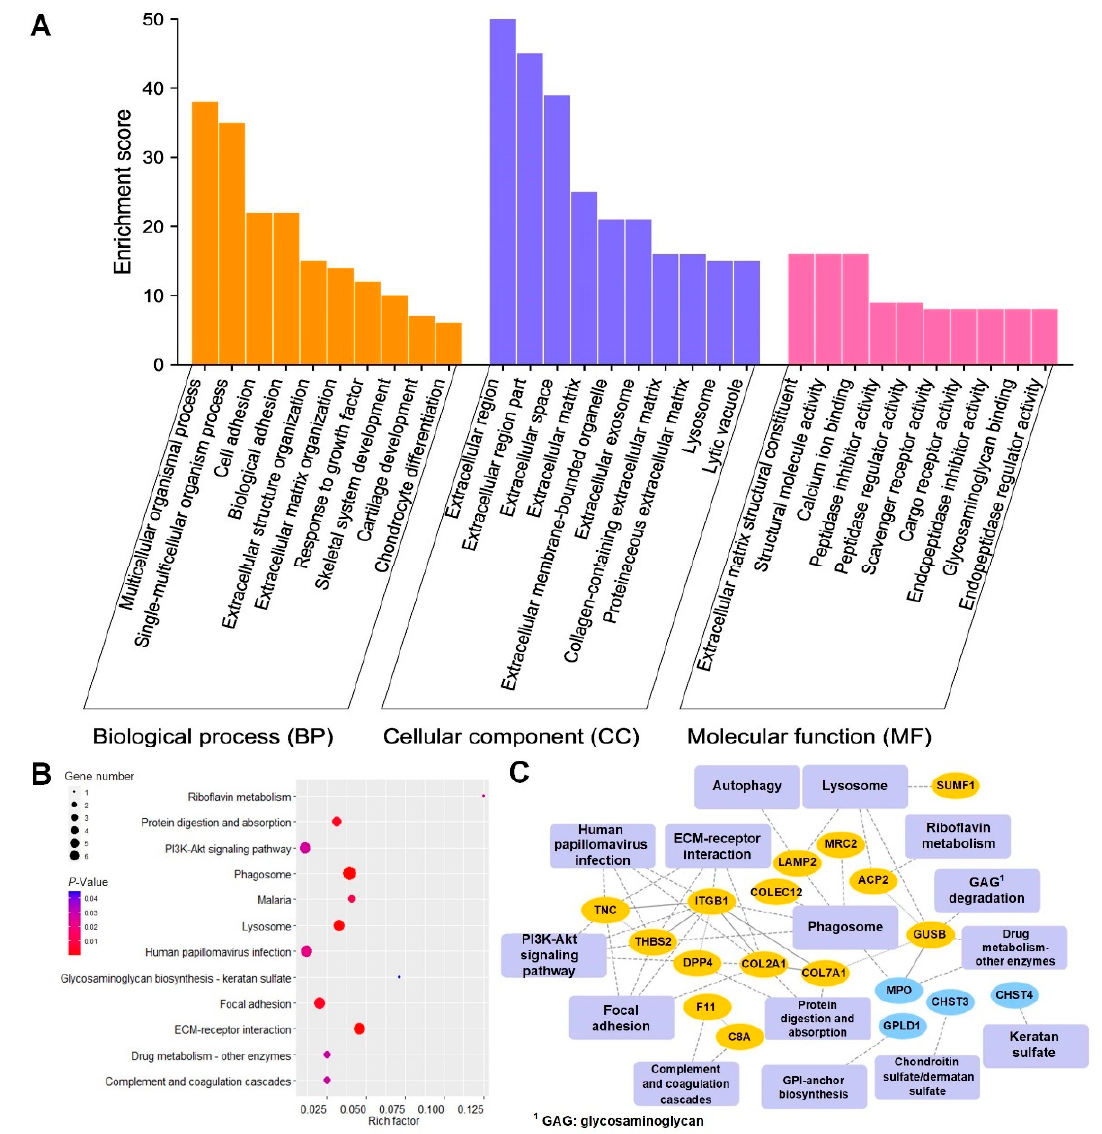
Figure 6. GO, KEGG pathway, and PPI analysis results of differentially expressed N-glycoproteins in KBD vs. N. ( A ) GO analysis of the differentially expressed N-glycoproteins of cartilage in KBD vs. N. ( B ) Bubble diagram of KEGG pathways in KBD vs. N. The blue to red gradient of bubbles of KEGG pathways represents the significance from low to high, respectively. Bubble size represents the number of differentially expressed N-glycoproteins in the KEGG pathway. ( C ) PPI network between KBD and N. Rectangles represent KEGG pathways, and circles represent N-glycoproteins. Solid lines mean the relationship has been verified by research, dashed lines mean the relationship has not been verified. The yellow and blue colors of the N-glycoproteins represent up-regulated and down-regulated, respectively.